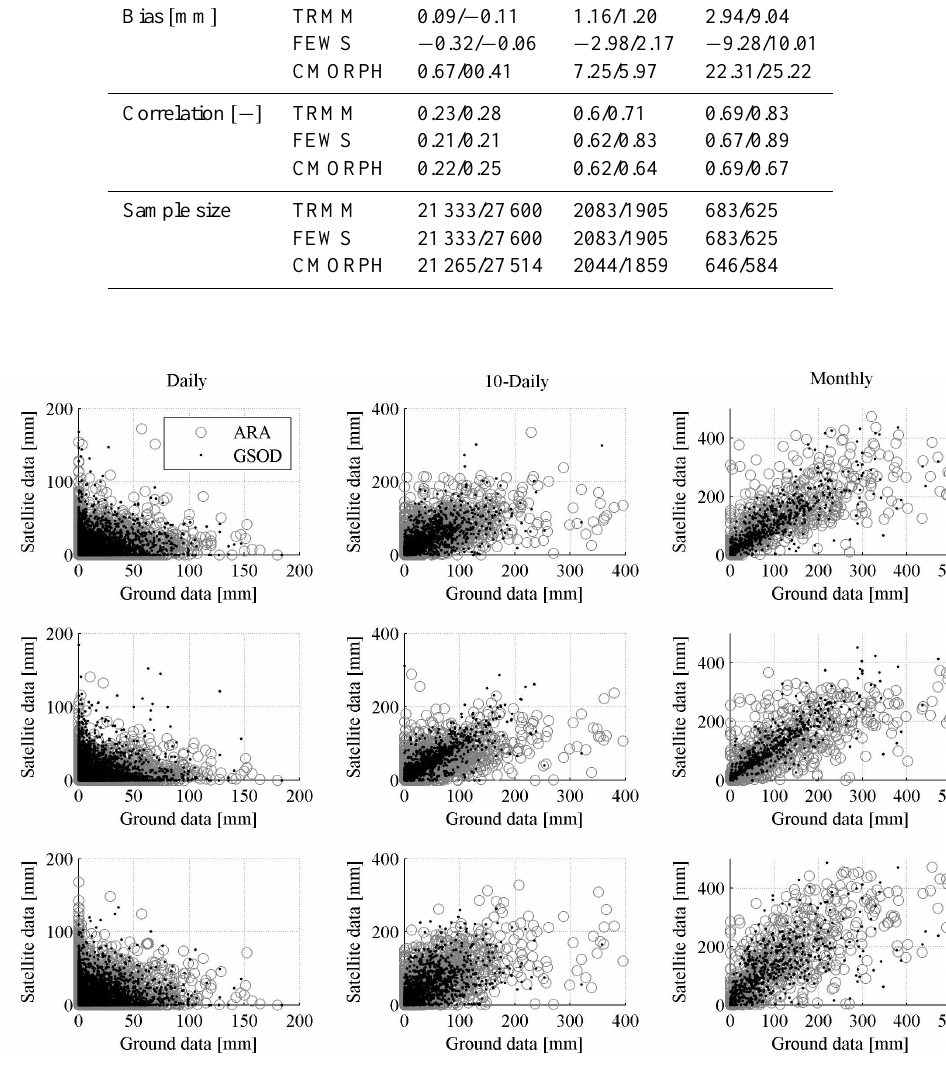
The two ground data sets, GSOD and ARA, are separated for the analysis as they come from different sources and do not cover the same area of the basin. Both sets of data (satel- lite product versus gauge data) are plotted at daily, 10-daily and monthly time steps for the pixels on which at least one gauge is available (Fig. 5). The associated global character- istics: correlation ( R ), bias (Eq. 4) and sample size are listed in Table